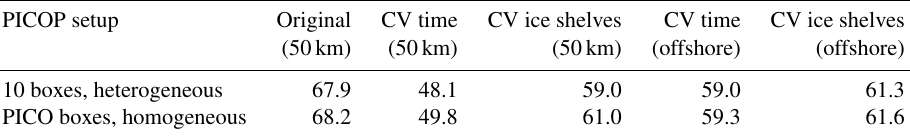
Table 9. Root-mean-squared error (RMSE int ) between the reference (NEMO) and parameterised (PICOP parameterisation) yearly integrated ice-shelf melt [Gtyr − 1 ] over the 35 individual ice shelves and 127 simulation years using the original parameters (Reese et al., 2018a; Lazeroms et al., 2019). RMSE int over the synthetically independent evaluation dataset resulting from the cross-validation (CV) over time and the cross-validation over ice shelves.